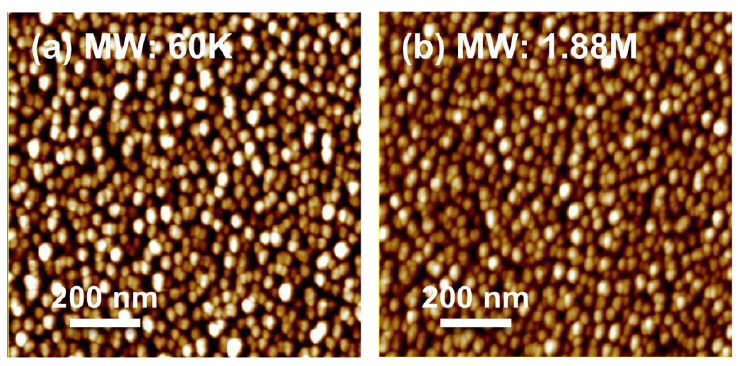
Figure 3. AFM images of Ar/O etched PS with bias voltage of −10 V and molecular 2 weights: ( a ) 60K g/mole (RMS: 4.92 nm), and ( b ) 1.88M g/mole (RMS: 4.19 nm) show similar surface morphology.